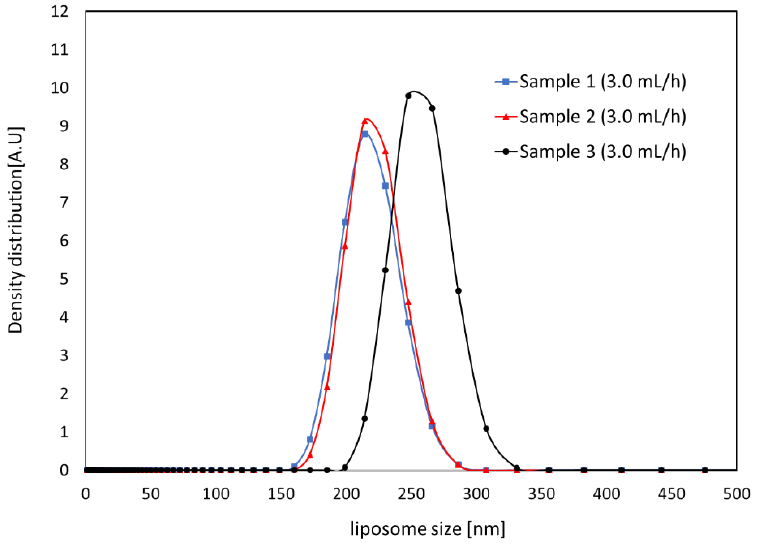
Figure 13. Liposome size distribution measured for three samples synthesized at 3.0 mL/h of lipid solution and 30 mL/h of saline.